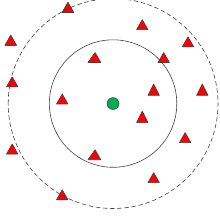
Figure 1. Data locality illustrated with k-nearest neighbor search